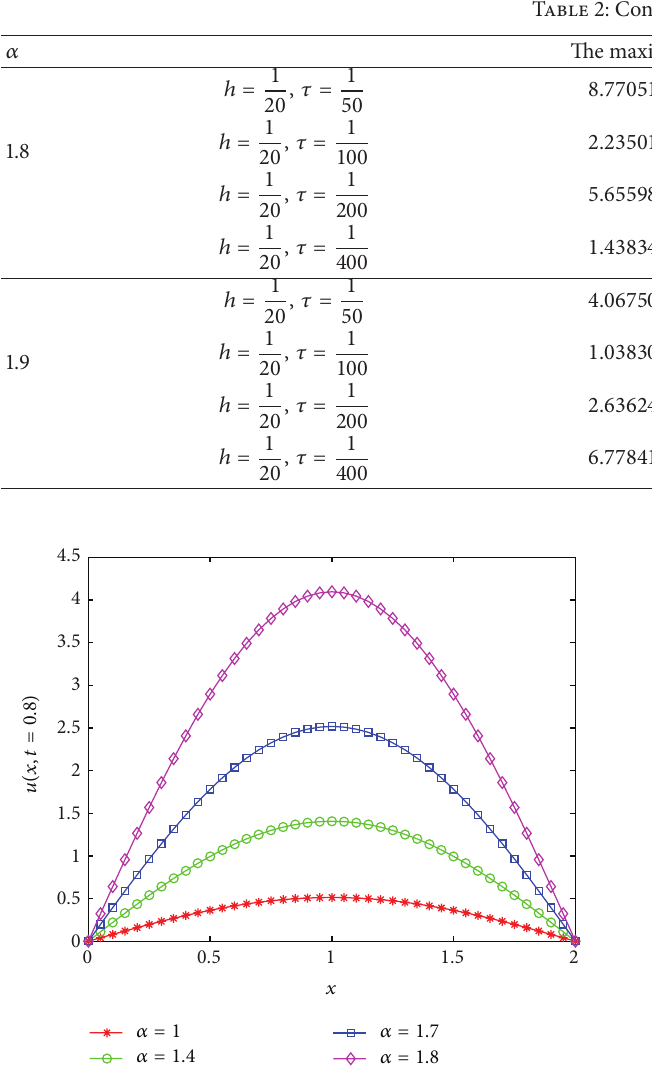
Figure 1: Dependence of the numerical solution for different values of 𝛼 by Numerical Algorithm I (see (38)) with 𝜏 = 0.002, ℎ = 0.0025 .